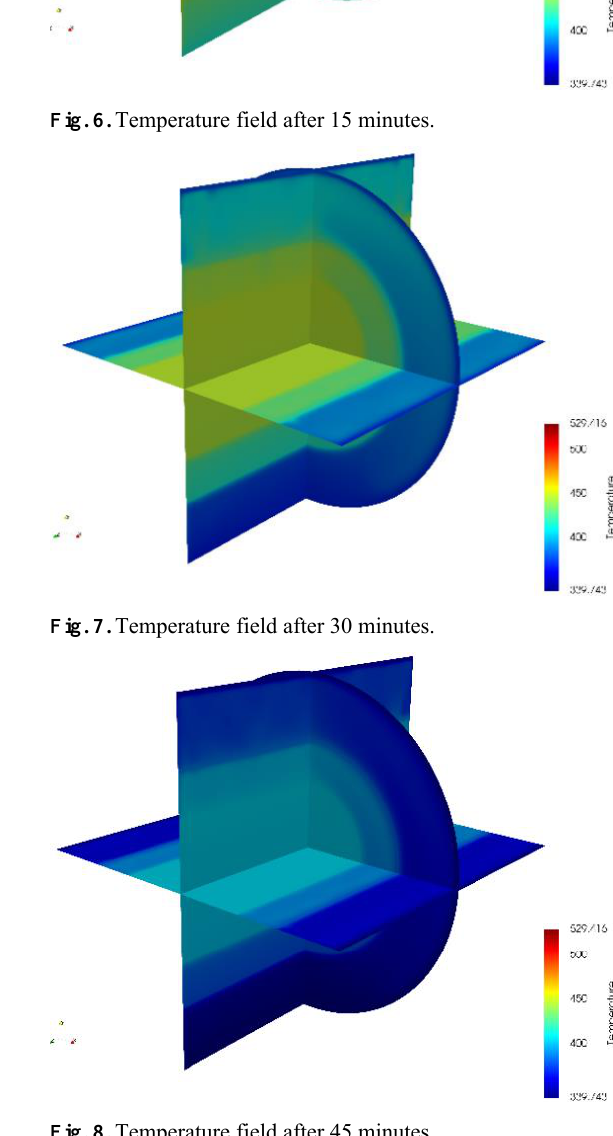
Fig. 8. Temperature field after 45 minutes